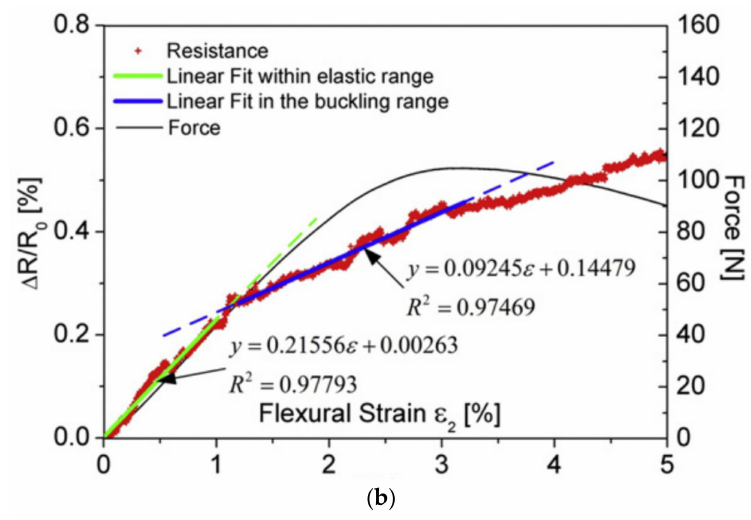
Figure 4. Linear fit of fractional change in resistance in two segments ( a ) versus the tensile strain, and ( b ) versus the flexural strain